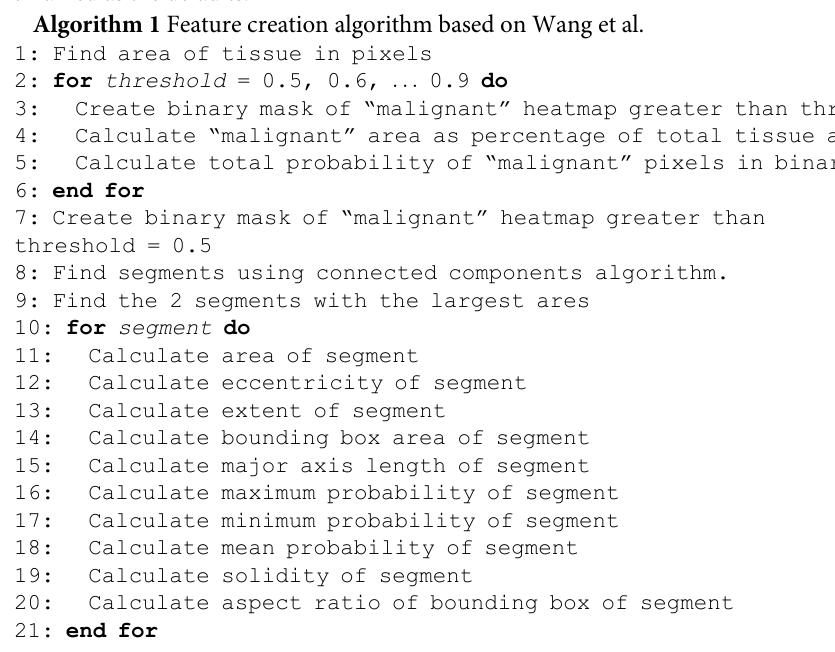
Algorithm 1 Feature creation algorithm based on Wang et al.